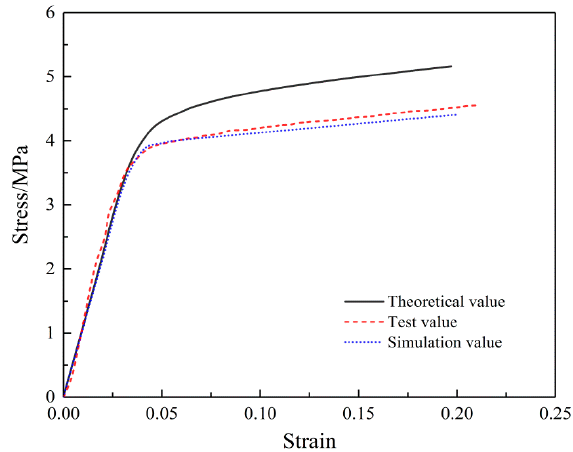
Figure 16. Comparison of the tensile stress-strain curves.